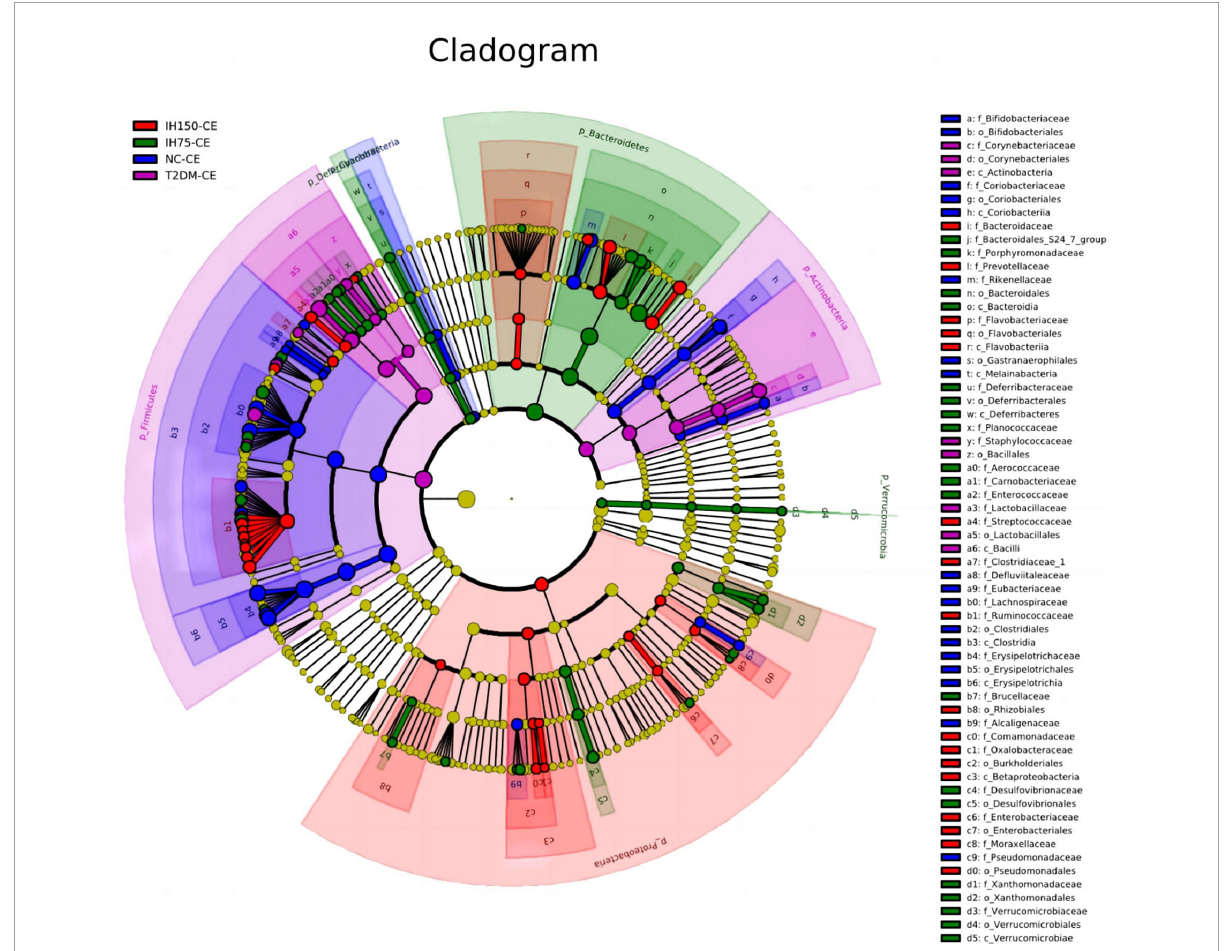
FIGURE8 Clustering tree of cecal microbiota. The different color nodes represent different groups. The species names indicated by the English letters in the picture are shown in the legend on the